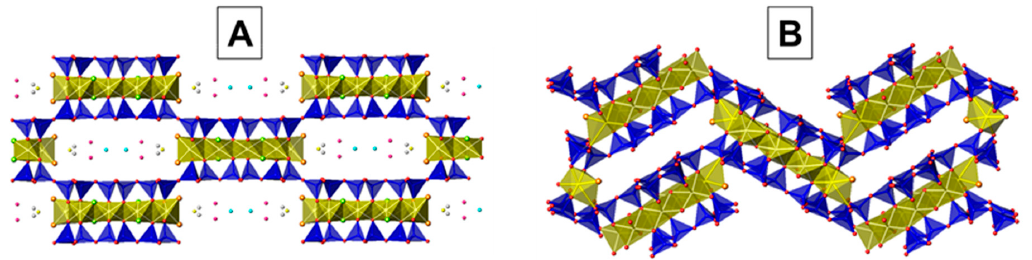
Figure 2. Schematic representation of sepiolite structure ( A ) before and ( B ) after thermal treatment.